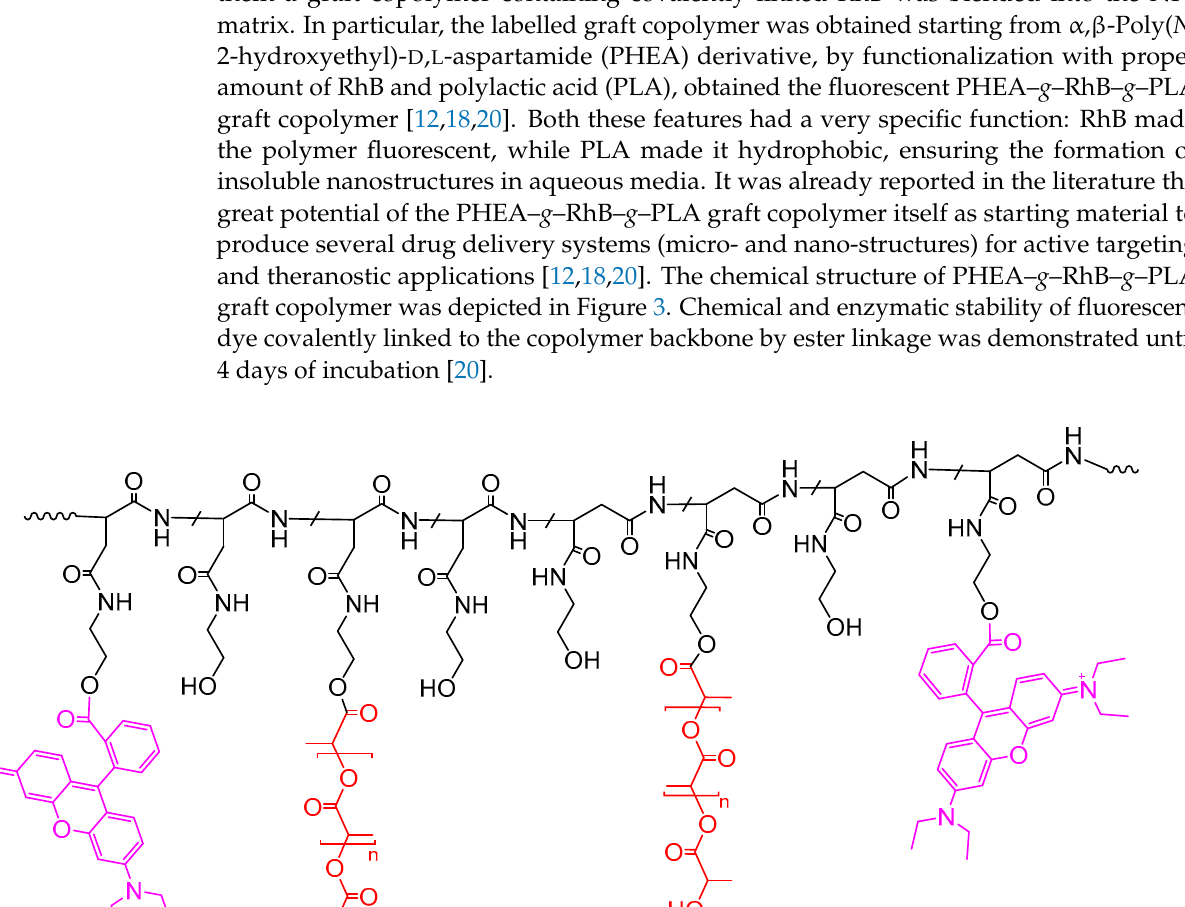
Figure 2. ( a ) Release profile of RhB from loaded-PNPs obtained from two different purification process, at 37 °C for 72 h; ( b ) Magnification of the 1% release profile.